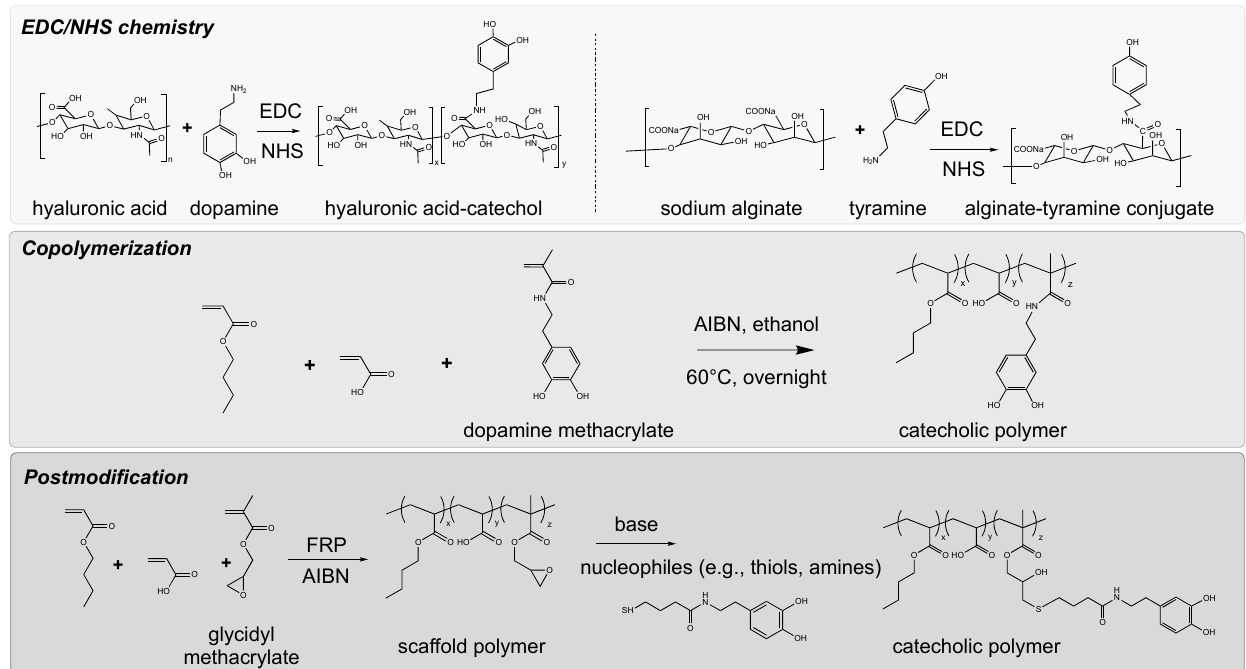
Figure 2. Synthetic scheme for producing polyphenolic materials.